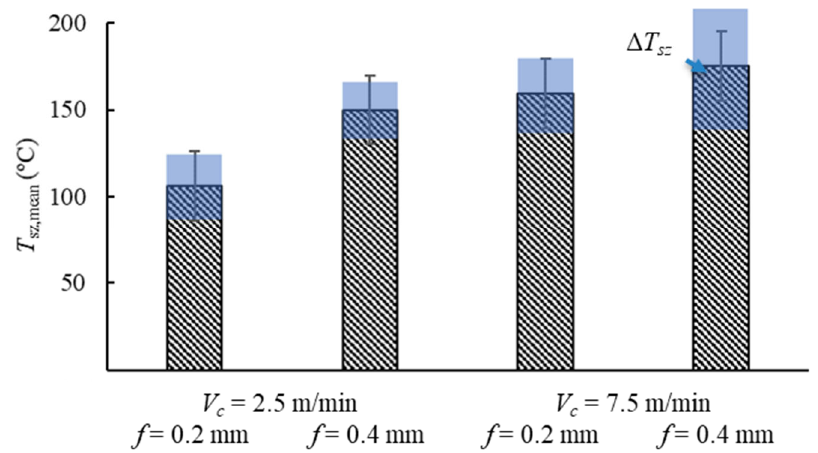
Figure 7. Effect of cutting conditions on workpiece temperature in the shear zone (amplitude of oscillation, ∆ T SZ , also included).